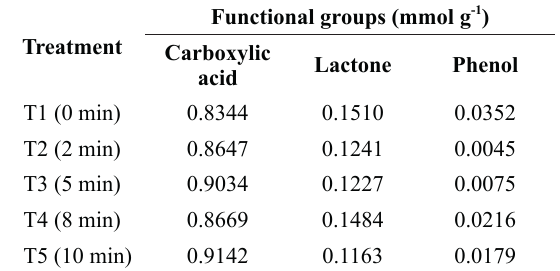
Quantity of functional groups according to